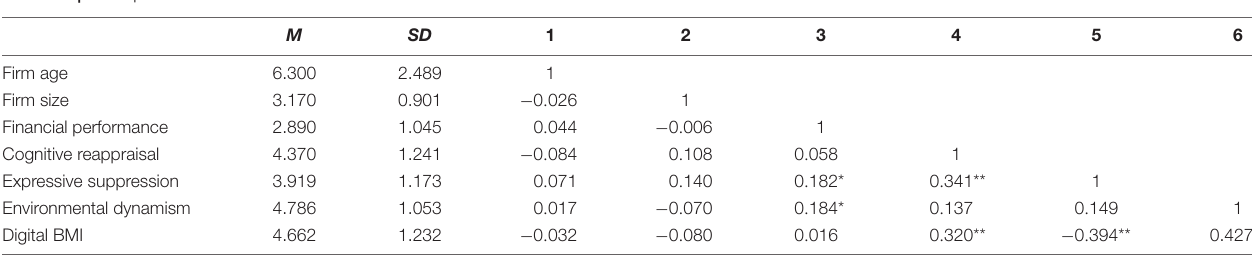
TABLE 2 | Description statistics and correlation